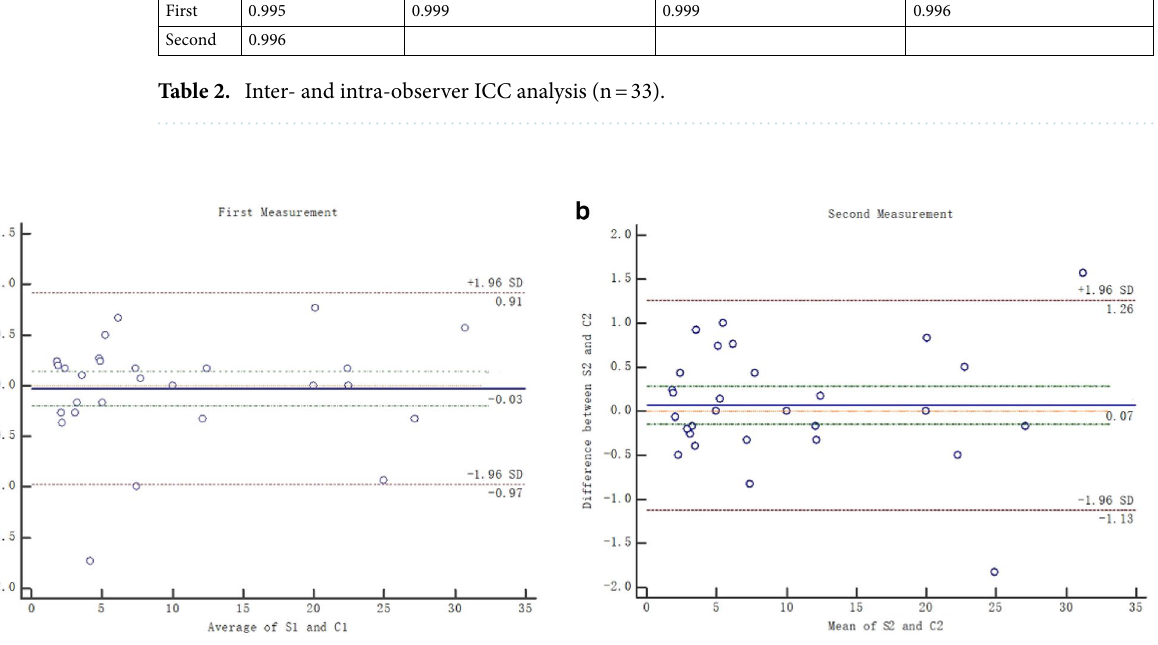
Figure 1. ( a , b ) Illustration of the Bland–Altman plot indicating the level of agreement between Sugaya and comparison card measurement of glenoid defect (two